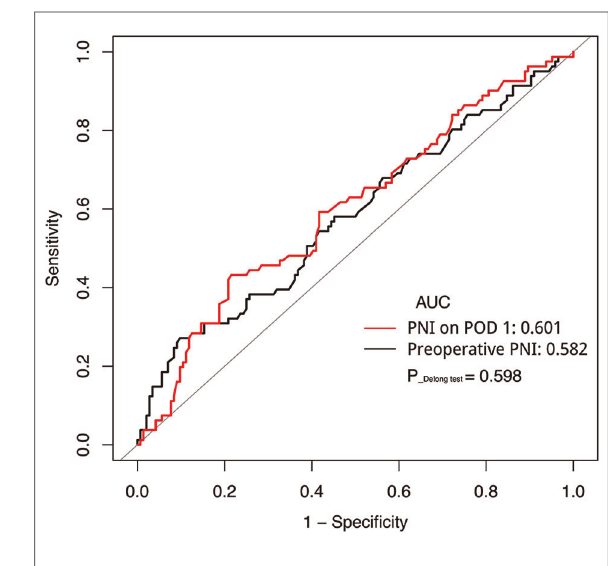
FIGURE 1 Receiver operating characteristic curve analysis of PNI preoperative and on POD 1 in predicting surgical complications. AUC, area under the curve; PNI, prognostic nutrition index; POD, postoperative